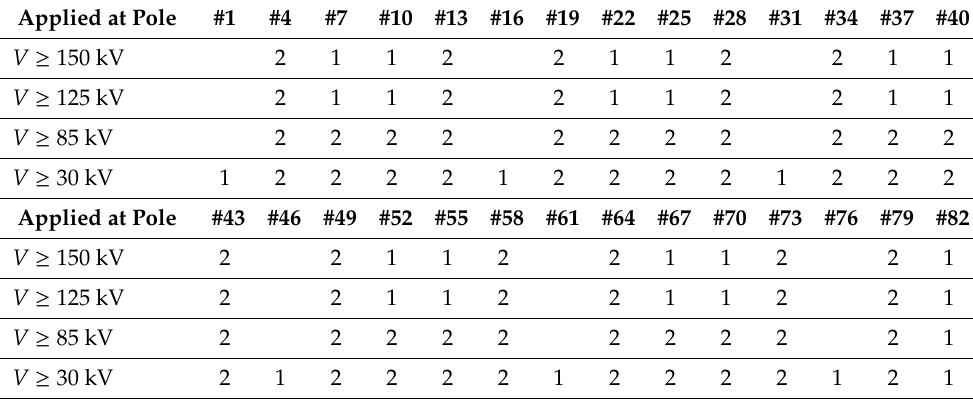
Table 4. Number of transformers with at least one phase reaching the critical overvoltage level. Case 1, dry poles and grounded transformer